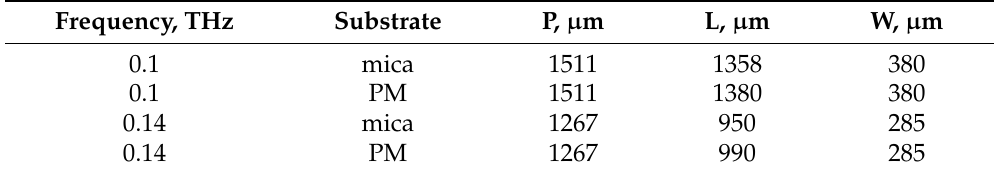
Table 5. Optimized geometry parameters of FSS for 0.1 and 0.14 THz. P—period, L—length, W—width.